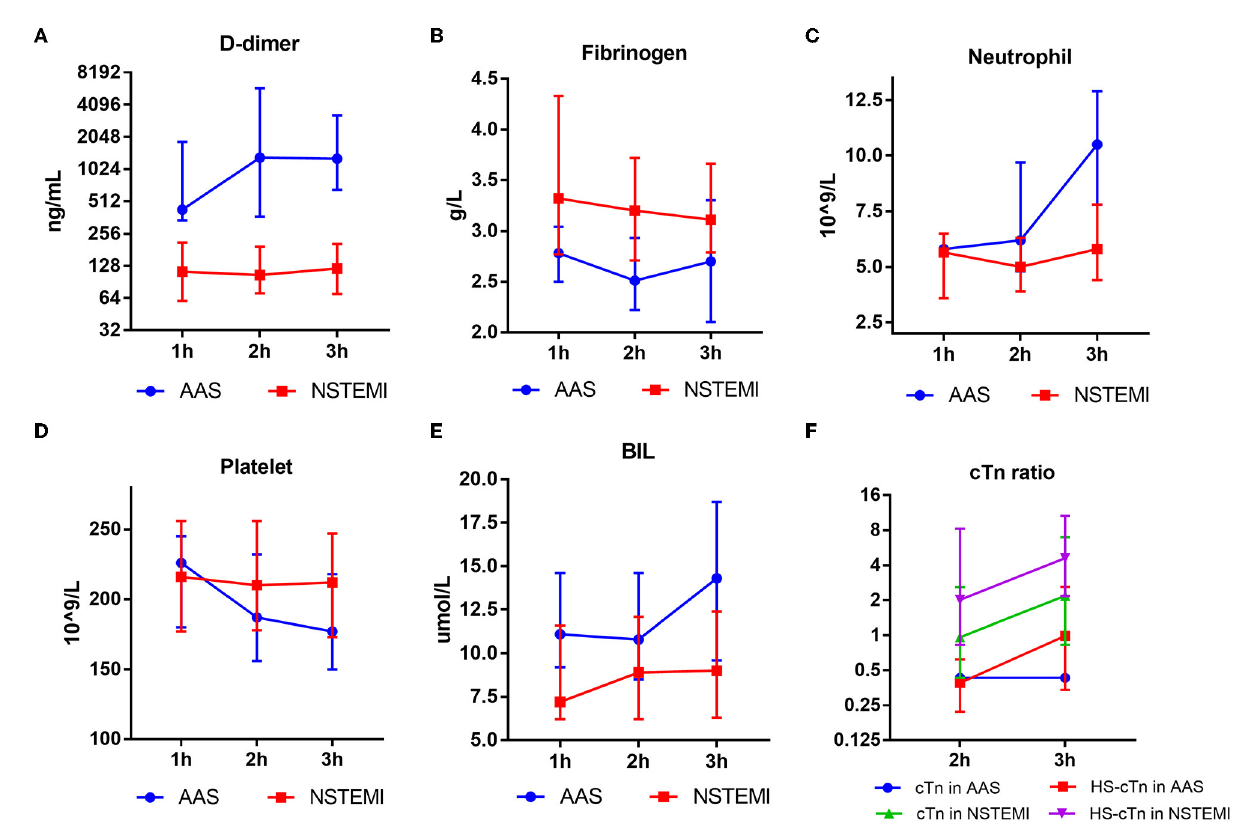
FIGURE6 Results of D-dimer (A) , fibrinogen (B) , neutrophil (C) , platelet (D) , BIL (E) , cTn ratio (F) of AAS and NSTEMI at different time points. AAS, acute aortic syndrome; BIL, bilirubin; HS-cTn, high-sensitivity cardiac troponin; NSTEMI, non-S T- elevation myocardial